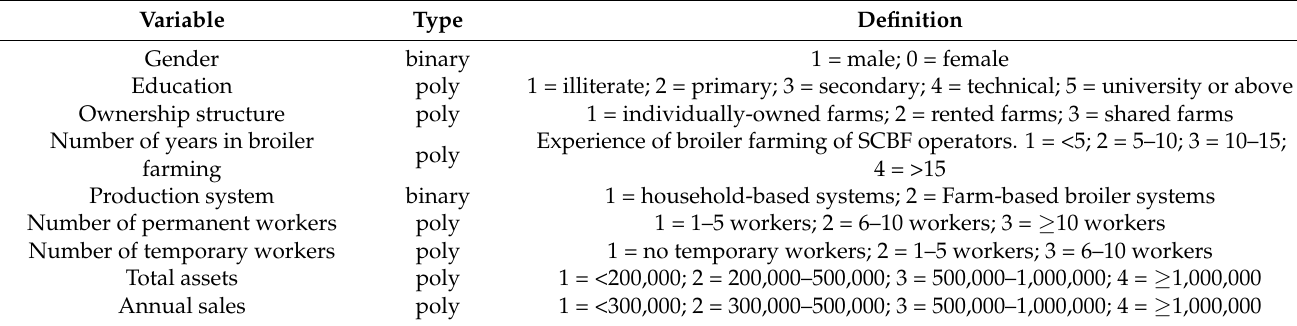
Table 2. Definition of variables used in the estimation of the ordered logit